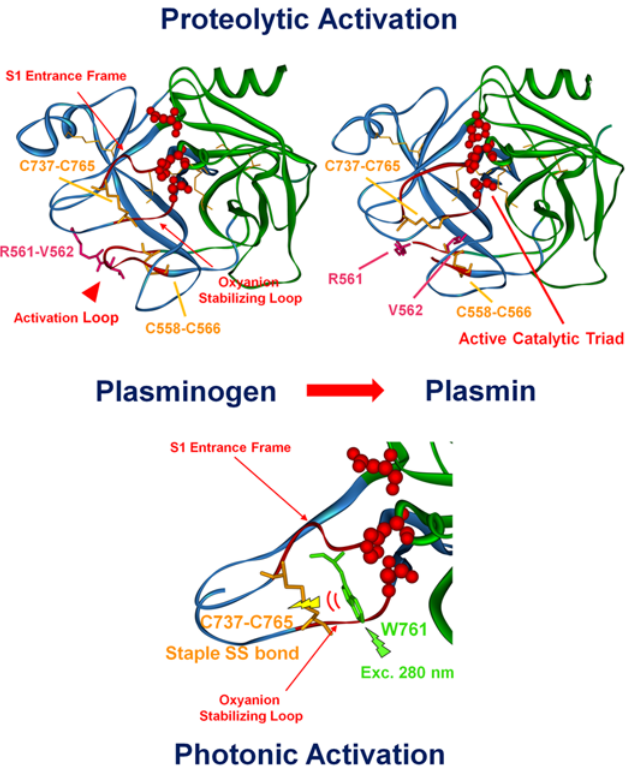
Fig 2. Proteolytic and photonic activation of plasminogen. 3D structures of the catalytic serine protease domain in plasminogen (to the left) and plasmin (to the right) (Ala543-Asn791). The xyz atomic coordinates for structural display were extracted from the crystallized structures of Glu1-Pmg (4A5T.pdb) [41] and activated plasminogen upon tight association with streptokinase (1BML.pdb) [4]. The C and N subdomains of plasminogen are displayed in blue and green, respectively. The disulphide bonds are displayed in stick configuration (orange) and two important disulphide bonds are highlighted: Cys556-Cys566 and Cys737- Cys765. The Trp and Tyr residues in the Serine Protease domain are displayed in line configuration (dark green). The active site residues (catalytic triad His603, Asp646 and Ser741 for plasminogen, His603, Asp646 and mutated Ala741 for plasmin) are displayed in CPK red (0.5 Å radius). The three important loops involved in plasminogen activation are displayed as red CPK: the oxyanion stabilizing loop, the S1 entrance frame and the activation loop. Top panel: The peptide bond Arg561-Val562 (in pink) in the activation loop is cleaved upon streptokinase activation leading to a conformational change and activating the catalytic triad (plasmin image to the right). Bottom panel: we can see in more detail the region around the oxyanion stabilizing loop, the S1 entrance frame. We observe a conformational change upon plasminogen activation involving the disulphide bond Cys737-Cys765 and Trp 761. We assume that upon UV illumination of plasminogen, Trp761 transfers its excitation energy to Cys737-Cys765. This results in disruption of this disulphide bond, leading to a conformational change that renders the catalytic triad